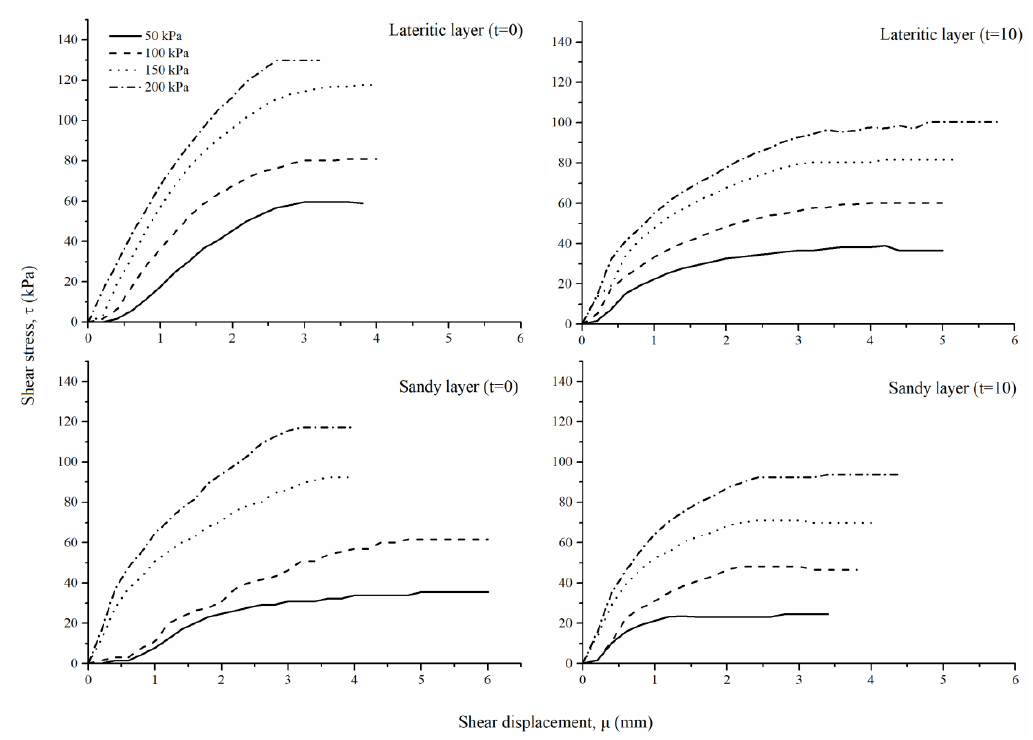
Figure 7. The typical stress – strain curves of experimental soils under W-D cycles.